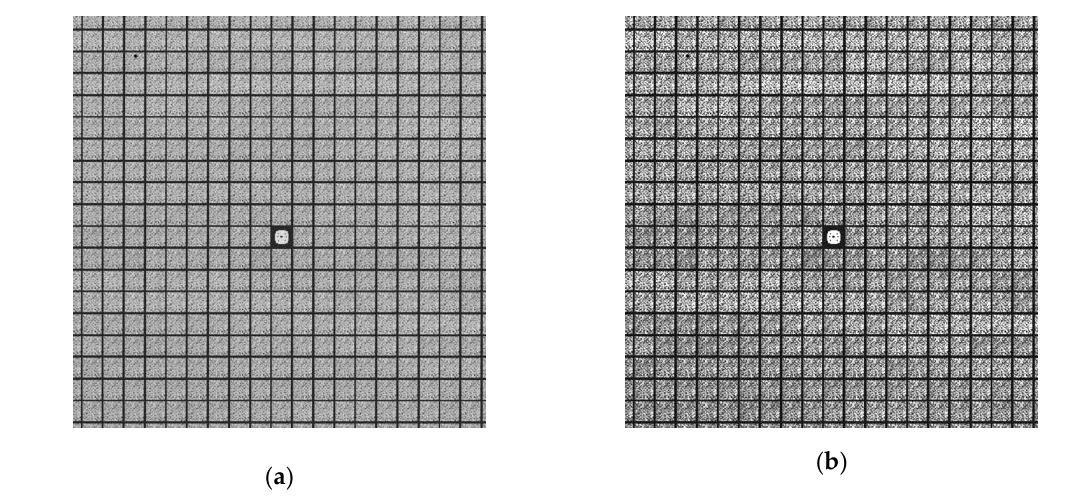
Figure 2. Cropped patch from Figure 1: ( a ) before and ( b ) after histogram